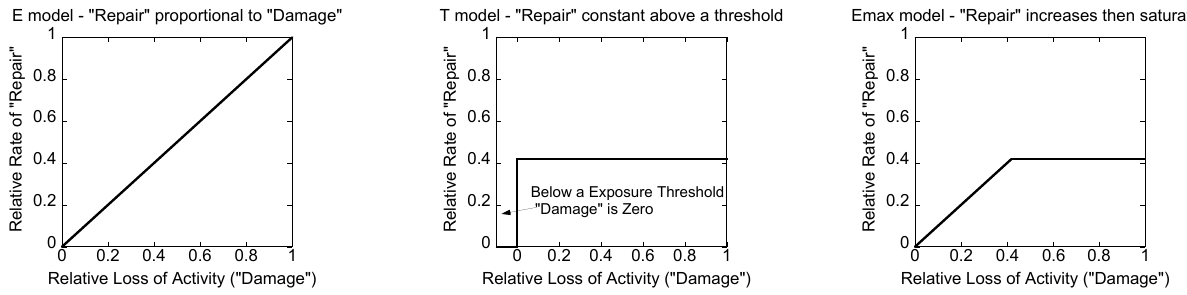
Figure 1. Graphical illustration of the implied dependence of repair and damage rates for the E , T and E max models. Table 2.